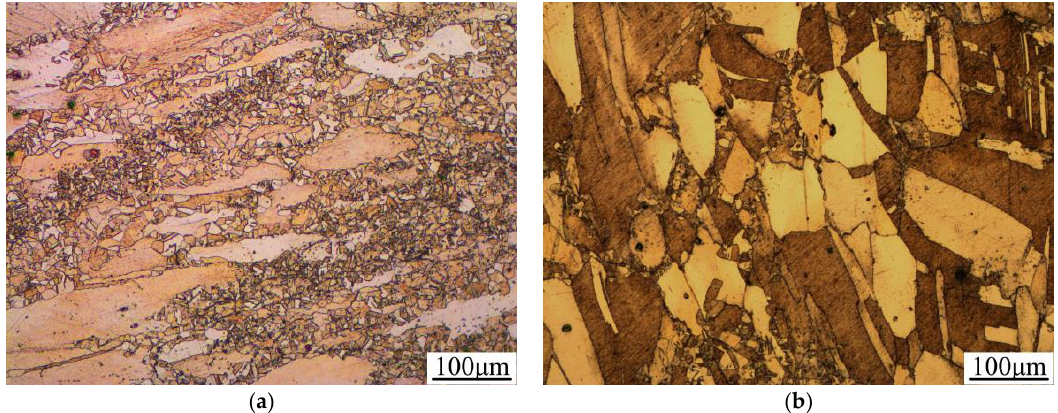
Figure 4. The metallographs under the conditions of ( a ) 1203 K and 0.01 s −1 and ( b ) 1353 K and 0.01 s −1 .